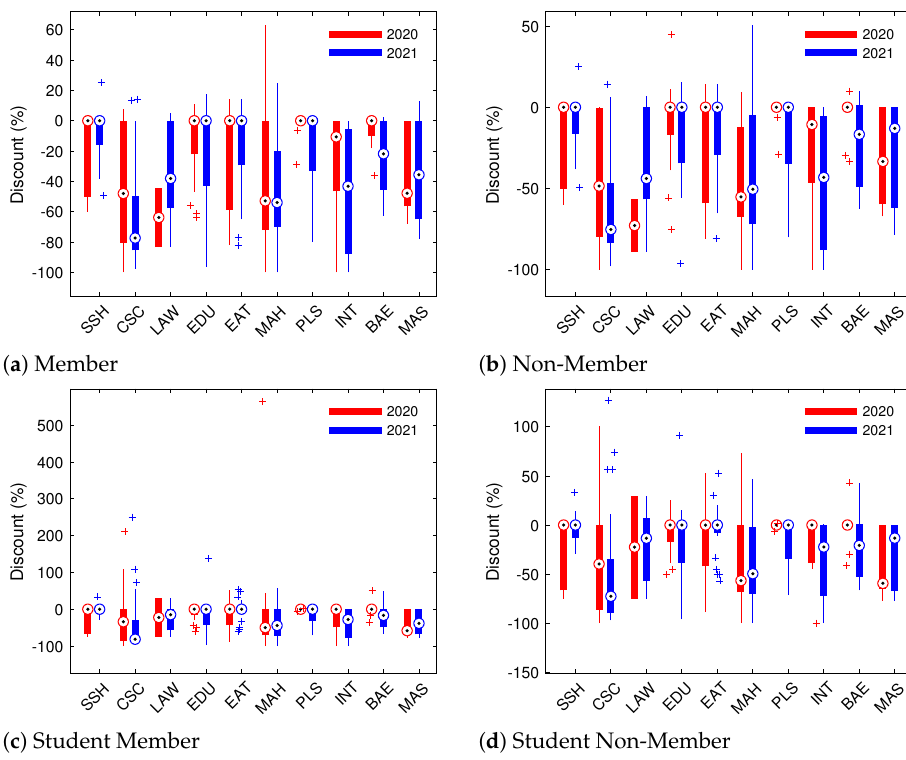
Figure A8. Distributions of the discount rates of registration fees of virtual conferences held in 2020 and 2021 with respect to the